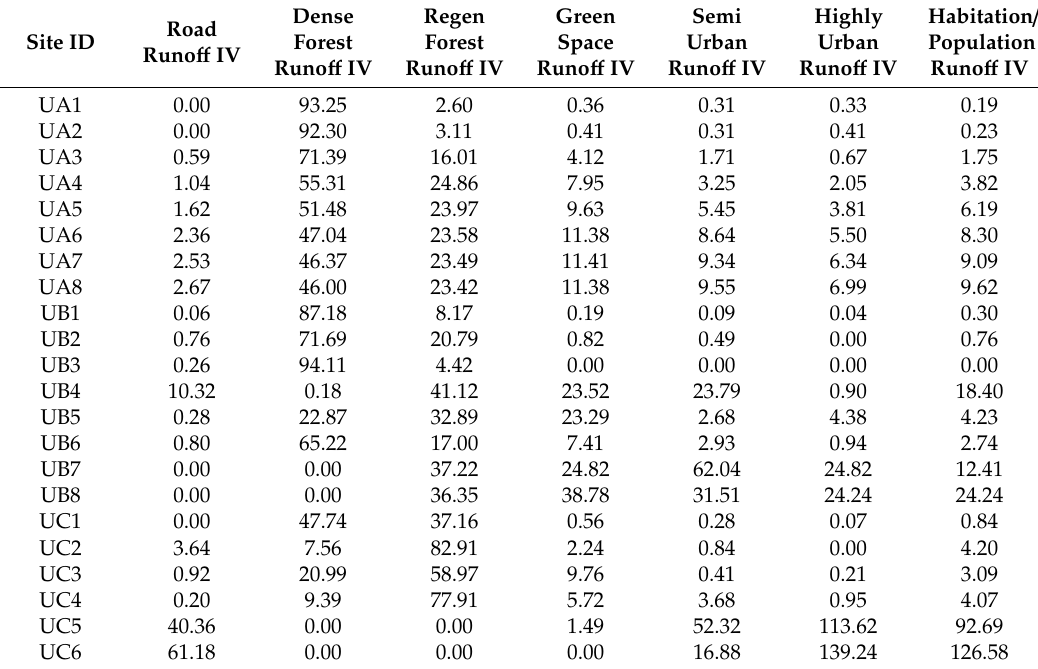
Table 3. Relative importance values (IV) for di ff erent factor runo ff at 22 WQ sampling sites in the Bumbu Watershed.